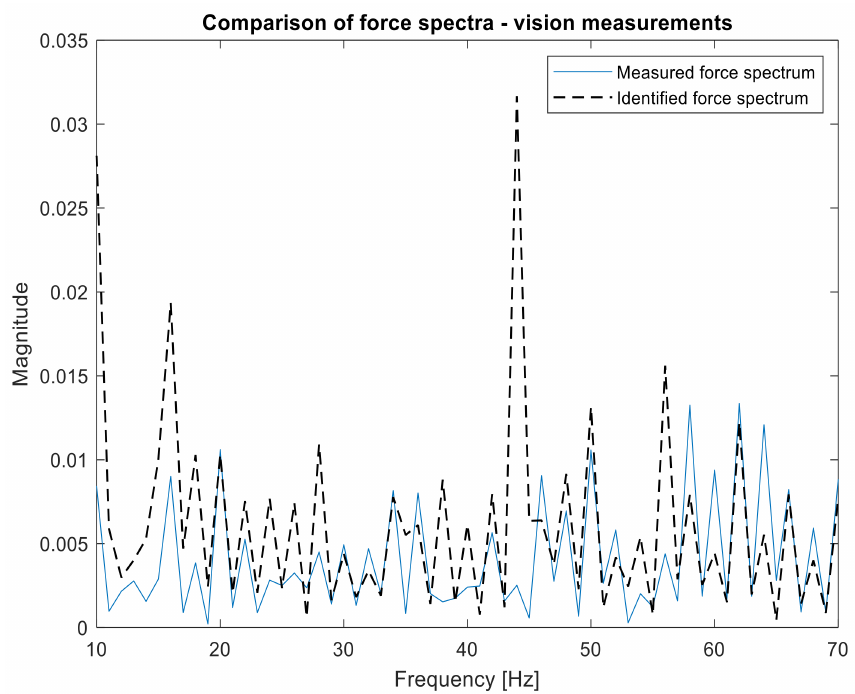
Figure 12. Comparison of measured and identified force spectra for the camera measurements (10 points—narrowed frequency